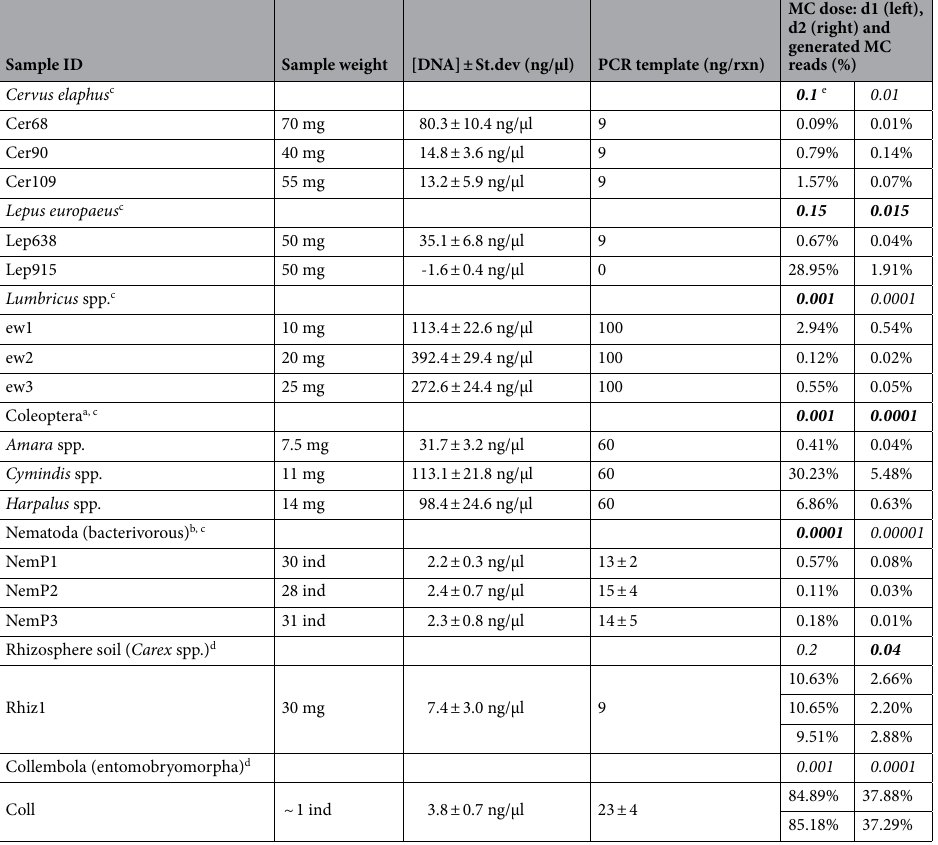
Table 3. Frequency of MC-SVs in each test sample. For each library (Sample ID), the table reports the corresponding taxonomic origin, the sample weight used for DNA extraction (Sample weight), the concentration and standard deviation of extracted DNAs ([DNA] ± St.dev), the MC dose and percentage of MC-SVs on the total number of reads (MC reads (%)). MC doses providing the best performances in terms of frequency of MC-SVs as well as alpha and beta diversity estimates are shown in bold. a Processing of 0.5 Harpalus spp. (~ 25 mg) with 0.33 MC dose generated 0.94% ± 0.02 MC reads. (data not shown). b Processing of 7 individuals with 0.12 MC dose generated 0.98% ± 0.01 MC reads (data not shown). c Biological replicates. d Technical replicates. e MC doses are in